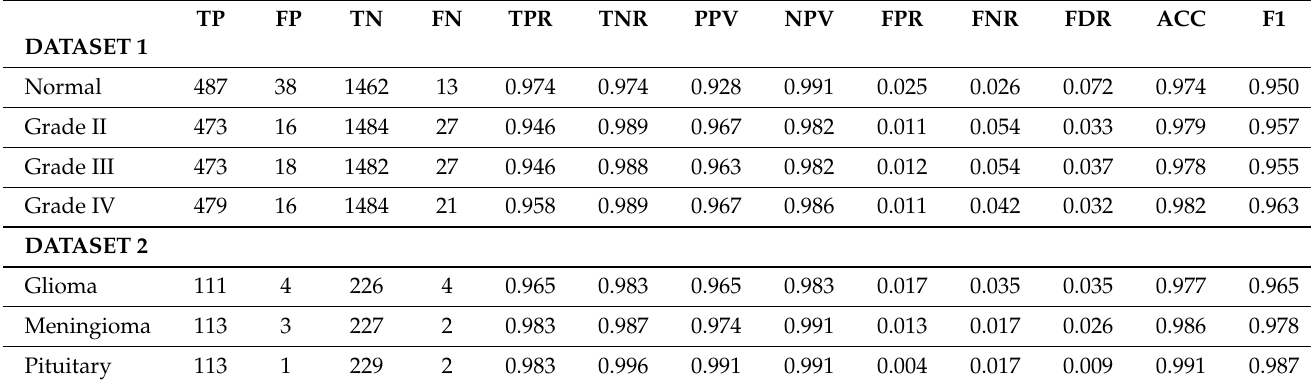
Table 10. MRI brain tumor classification performance metrics for proposed CNN + eHHO approach.